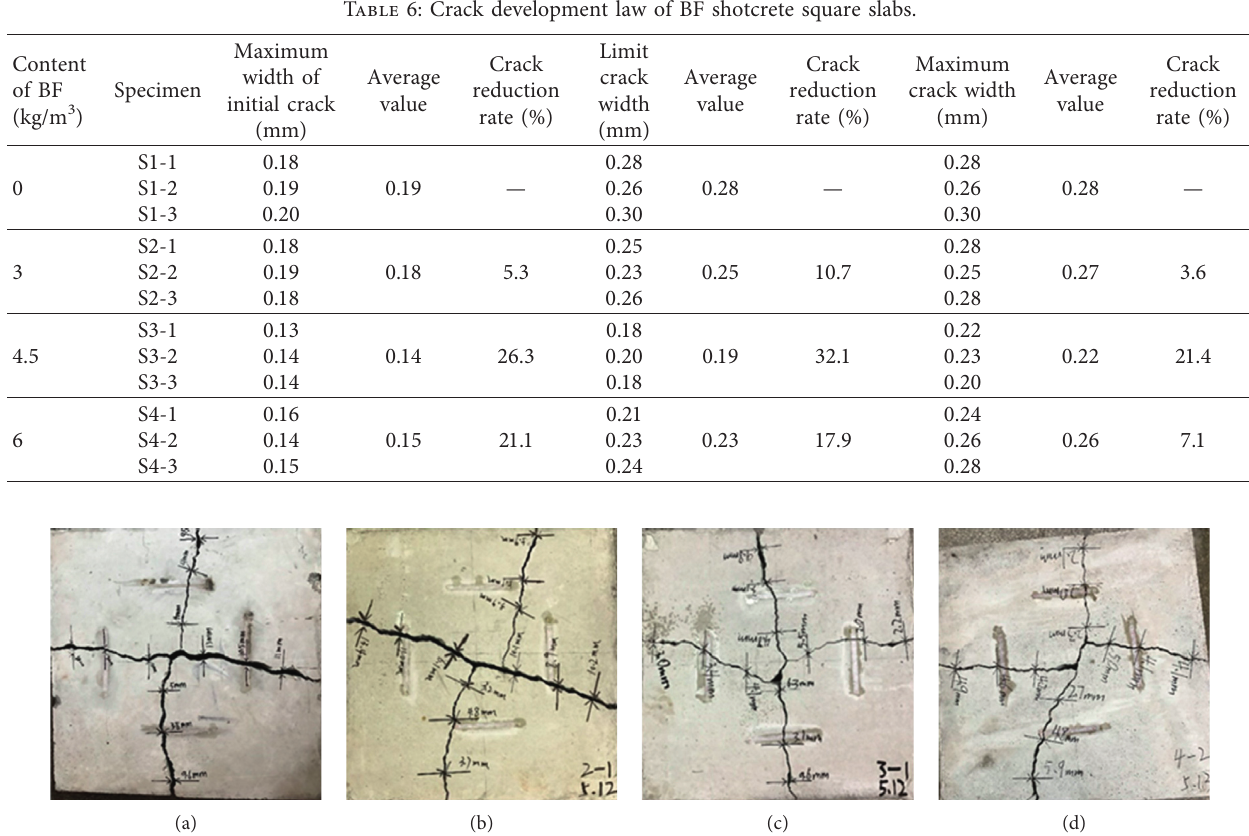
Figure 7: Failure modes of shotcrete slabs with different BF contents. (a) 0 kg/m 3 .(b) 3 kg/m 3 . (c) 4.5kg/m 3 .(d) 6kg/m 3 .